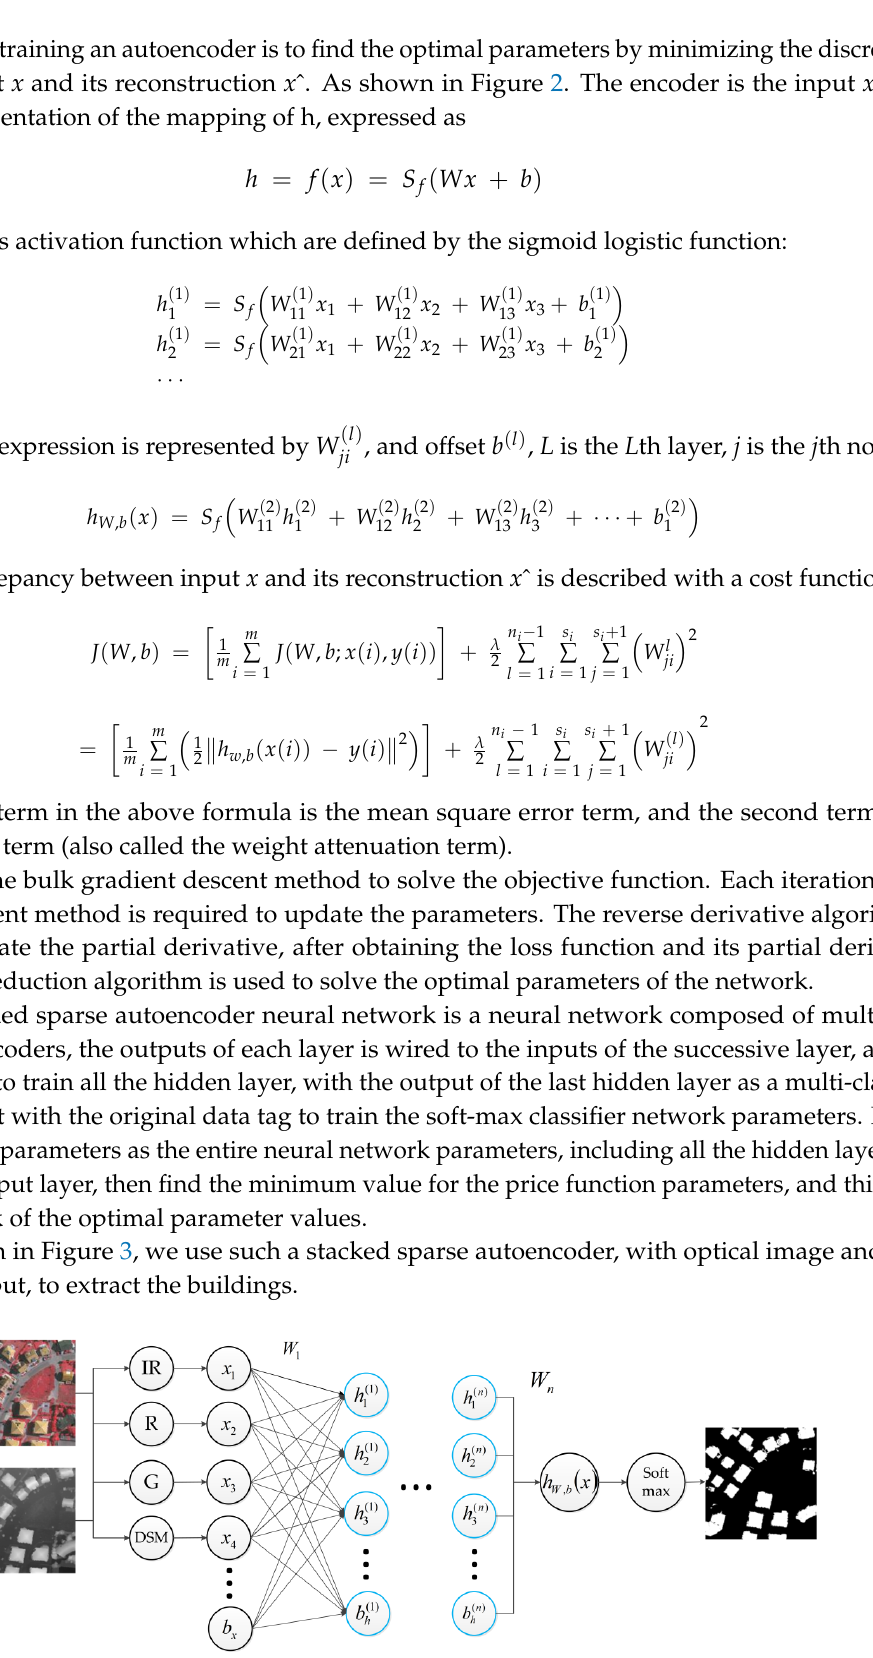
Figure 3. The illustration of the stacked sparse autoencoder used in this work.